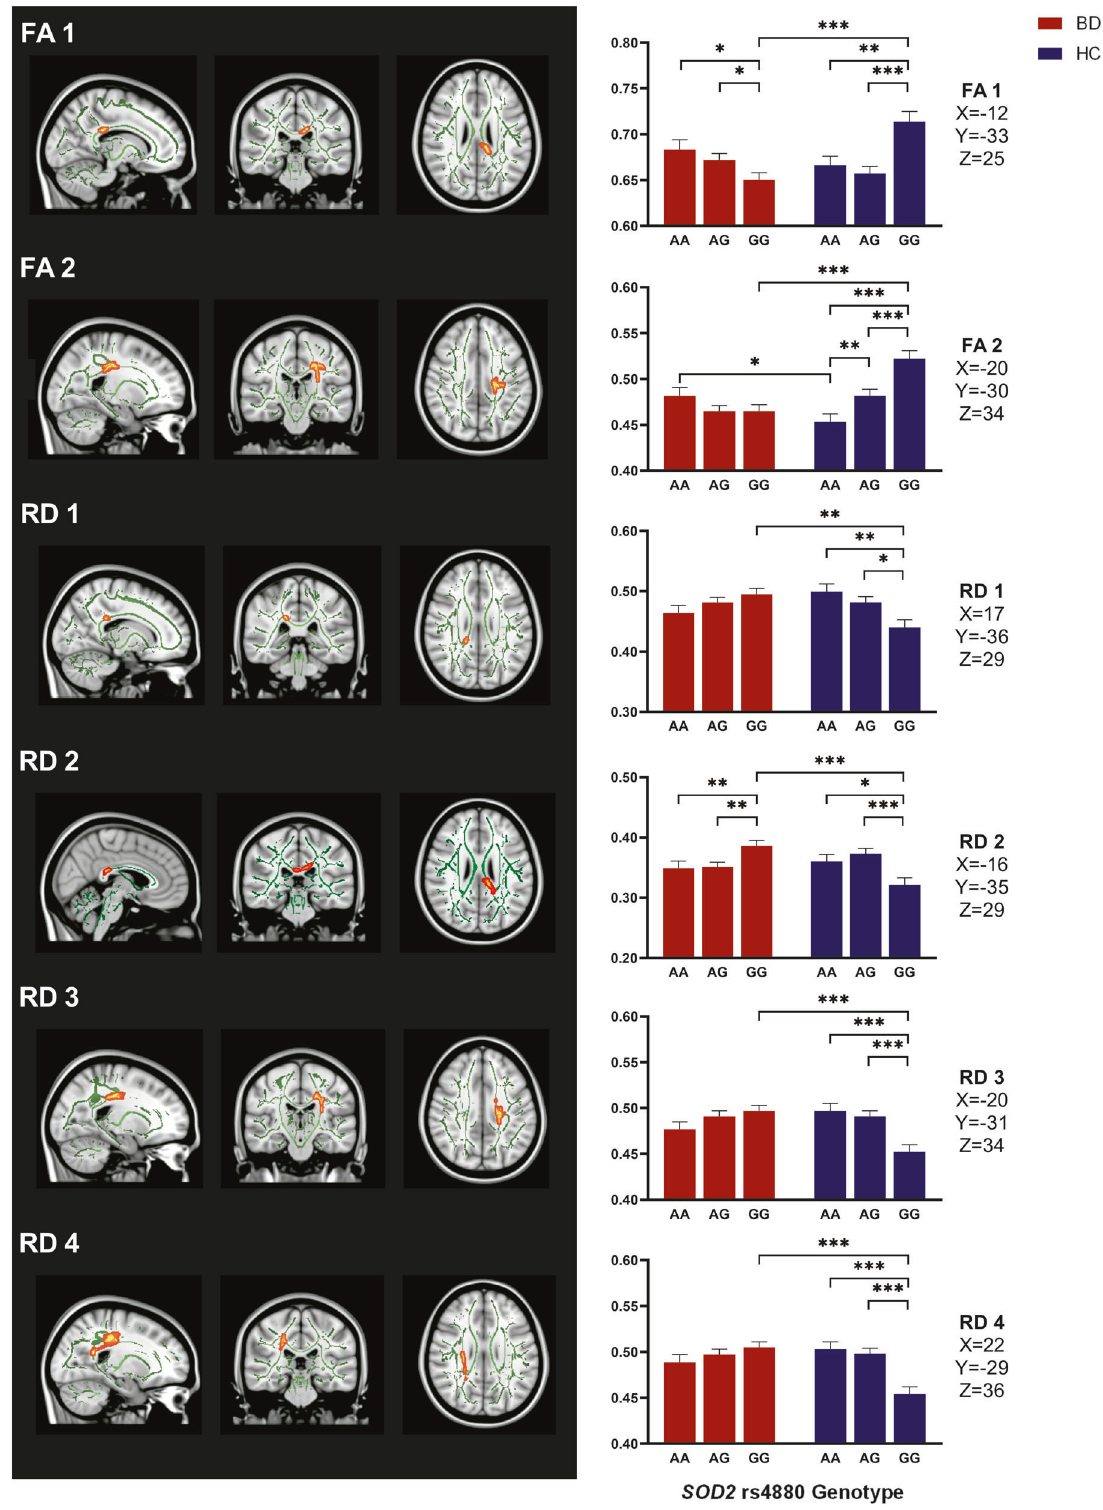
Fig. 1 Post hoc analyses for clusters with signi fi cant diagnosis-by-genotype interaction effects. * p < 0.05, ** p < 0.01, *** p < 0.001. FA1)-FA2) Diagnosis-by- SOD2 rs4880 interaction effect post-hoc results for signi fi cant FA clusters. FA1 cluster peaks in the splenium of the corpus callosum and FA2 cluster peaks in the posterior corona radiata and anterior thalamic radiation. RD1)-RD4) Diagnosis-by- SOD2 rs4880 interaction effect post-hoc results for signi fi cant RD clusters. RD1 peaks in the right and RD2 peaks in the left splenium of corpus callosum. RD3 peaks in the left and RD4 peaks in the right posterior corona radiata. Information regarding the peak anatomical location for each cluster was reported as unit of mm in the X, Y, and Z